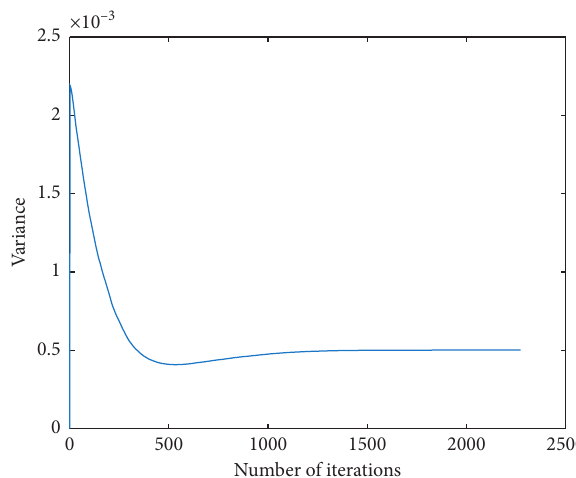
Figure 11: Changes in the variance of AMSGrad algorithm.